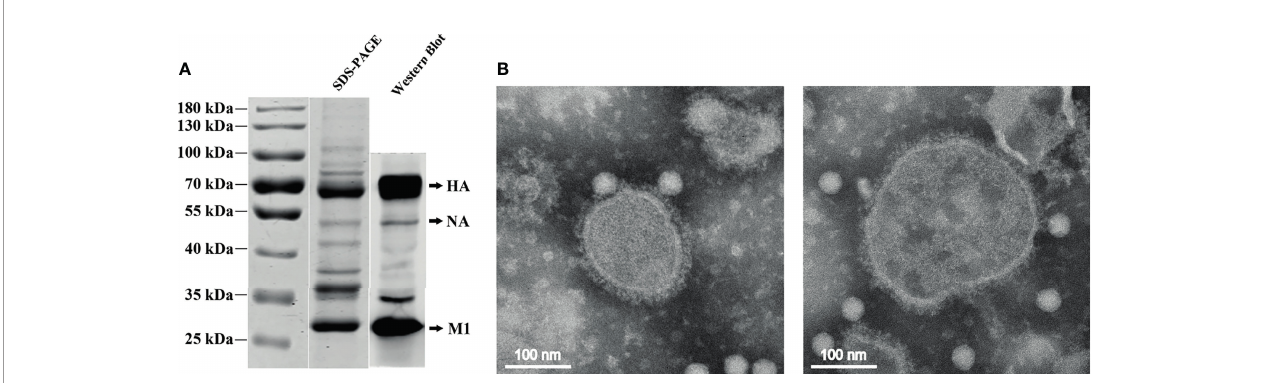
FIGURE 2 | SDS-PAGE, Western blotting, and electron microscopy of the puri fi ed H7N9 VLPs. (A) The purity of the puri fi ed H7N9 VLPs was analyzed using SDS- PAGE and validated by Western blotting with the anti-His-tag mouse monoclonal antibody. (B) Negative staining electron microscopy of the H7N9 VLPs. Puri fi ed VLPs were stained using 1% phosphotungstic acid.